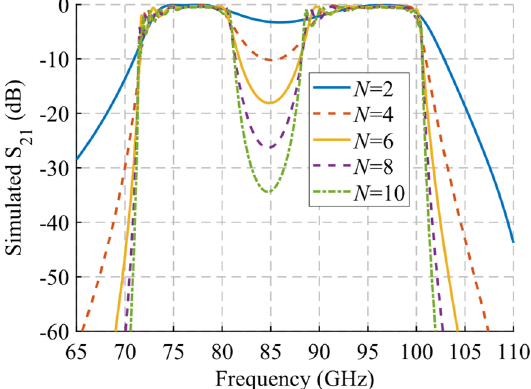
Figure 23. S 21 parameter for the single periodic ideal unit cell with different repetition number N of the unit cell at maximum symmetry breakage ( d = 0). the unit cell at maximum symmetry breakage ( d = 0).